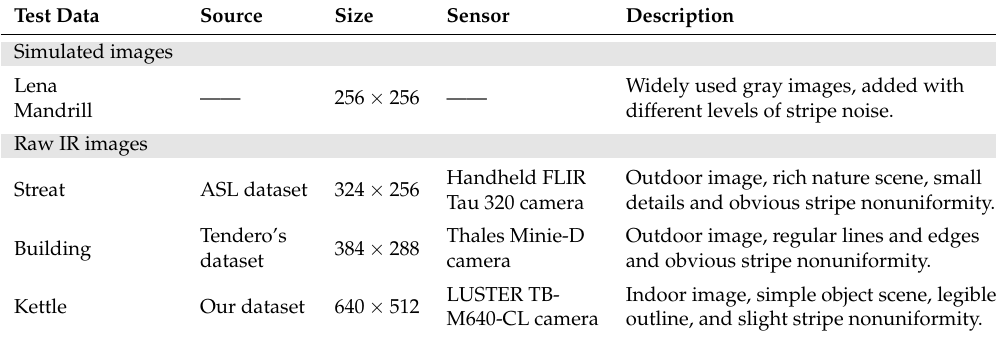
Table 1. The details of the test data.